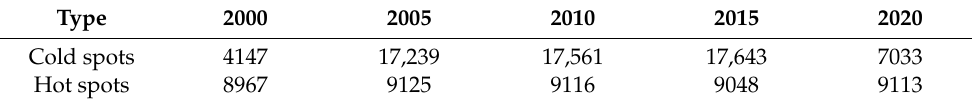
Figure 3. Spatial distribution of ESV per unit area during 2000–2020. Table 6. Changes in the number of ESV cold spots and hot spots during